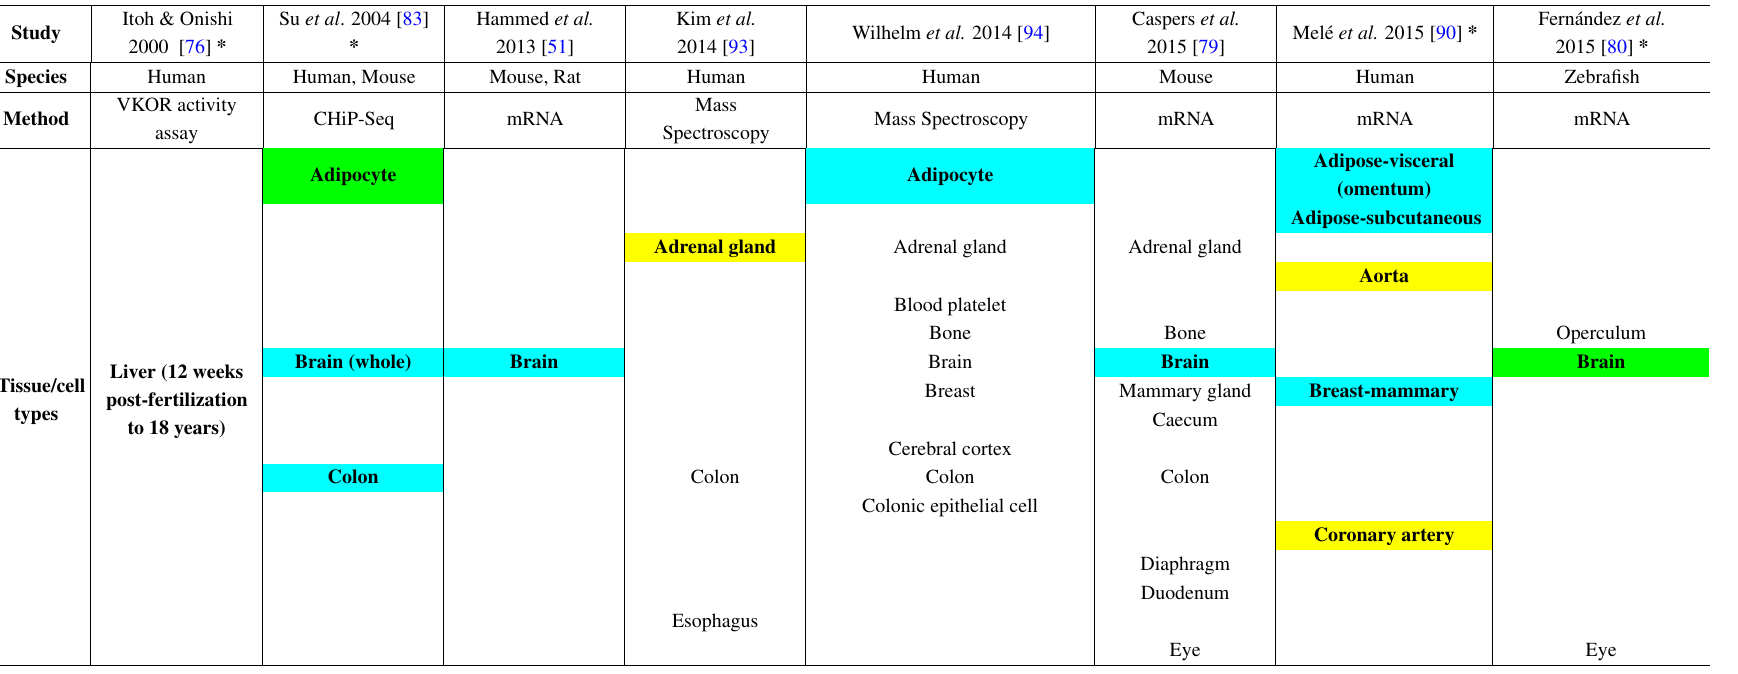
Table 2. Summary of results from expression studies of human, mouse and rat VKORC1 and